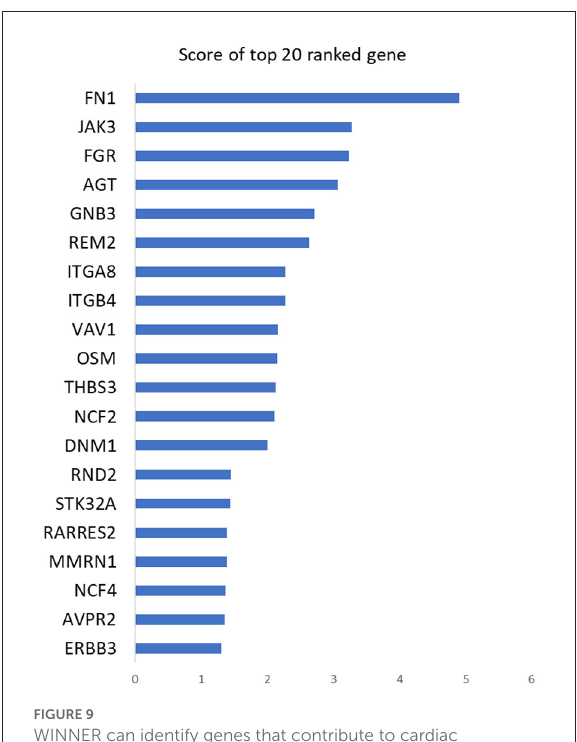
FIGURE9 WINNER can identify genes that contribute to cardiac regeneration from a list of differentially expressed genes. RNA-sequencing analyses of gene expression in the hearts of piglets that had or had not undergone surgically induced myocardial infarction on the 1st day after birth for a previous report (Zhu et al., 2018) were compared to generate a list of differentially expressed genes; then their gene-gene interactions were queried from HAPPI v2 database; then, the list was ranked via WINNER gene prioritization to determine which genes likely contributed to myocardial regeneration. The 20 top-ranked genes are displayed with their corresponding WINNER scores.